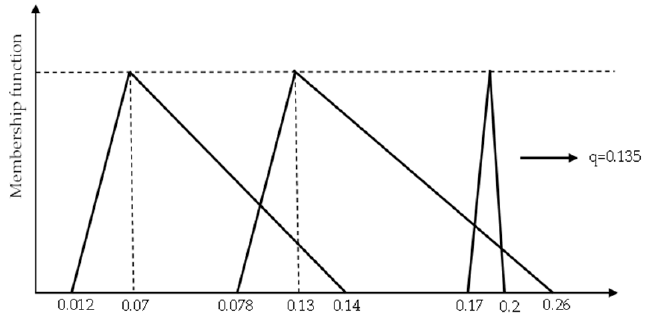
Figure 8. The weighted normalized values of linguistic expressions L1, M3 and L4. The region of risk for the treated example is obtained by using the procedure (Step 10 of the proposed Algorithm): max(0.15, 1) = 1, so, it follows, that the level of risk can be described as a moderate risk level. In a similar way, the level of risk is determined for all combinations of RF values, so that the fuzzy risk matrix is constructed, presented in Table 3: Table 3. Fuzzy risk matrix. Risk Level Risk Level Risk